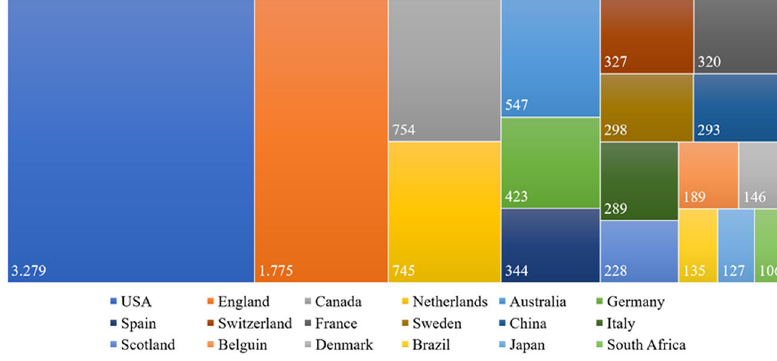
Fig. 3 Publications by country. Source: Web of Science, 2021.